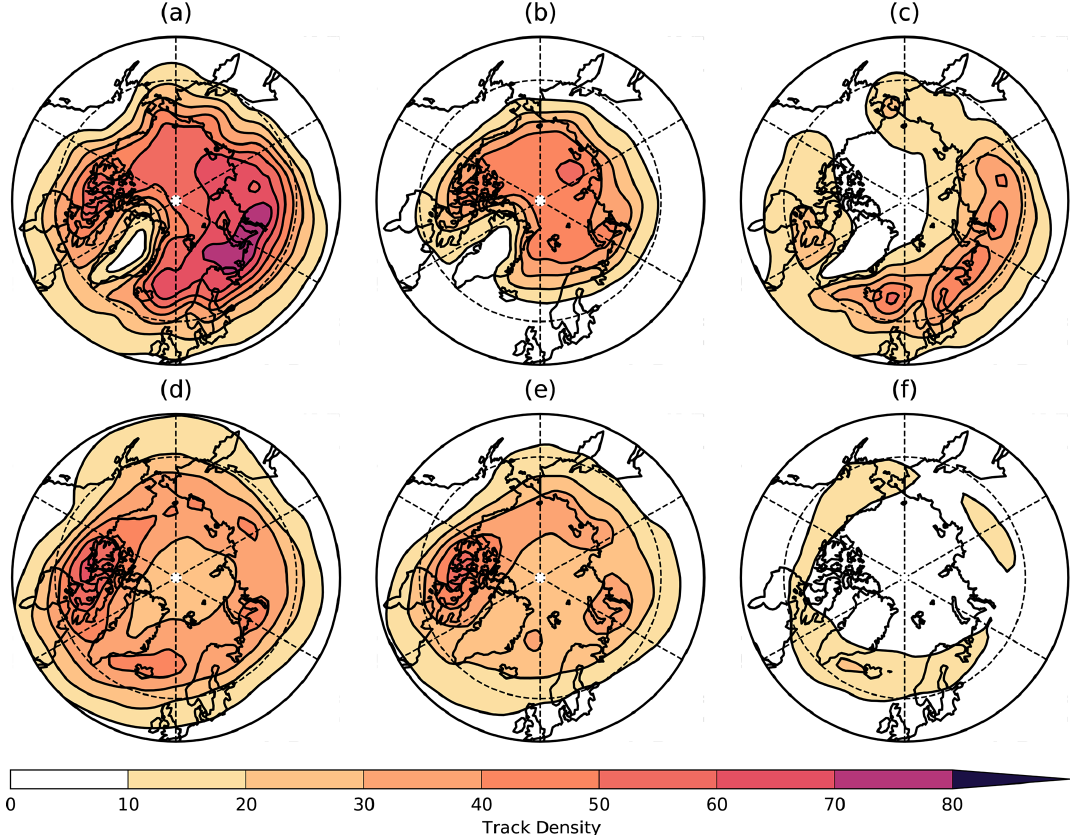
Figure 3. As for Fig. 2 but for track density. Panels (a–c) for Arctic cyclones and panels (d–f) for